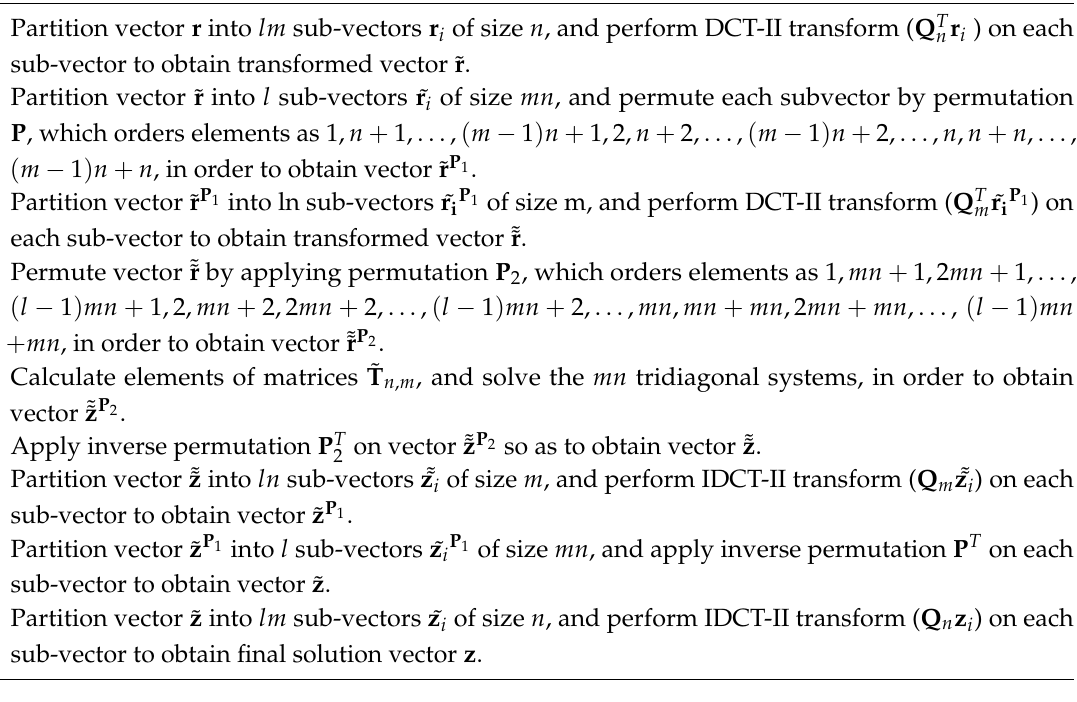
Algorithm 2 Preconditioner solution for the thermal